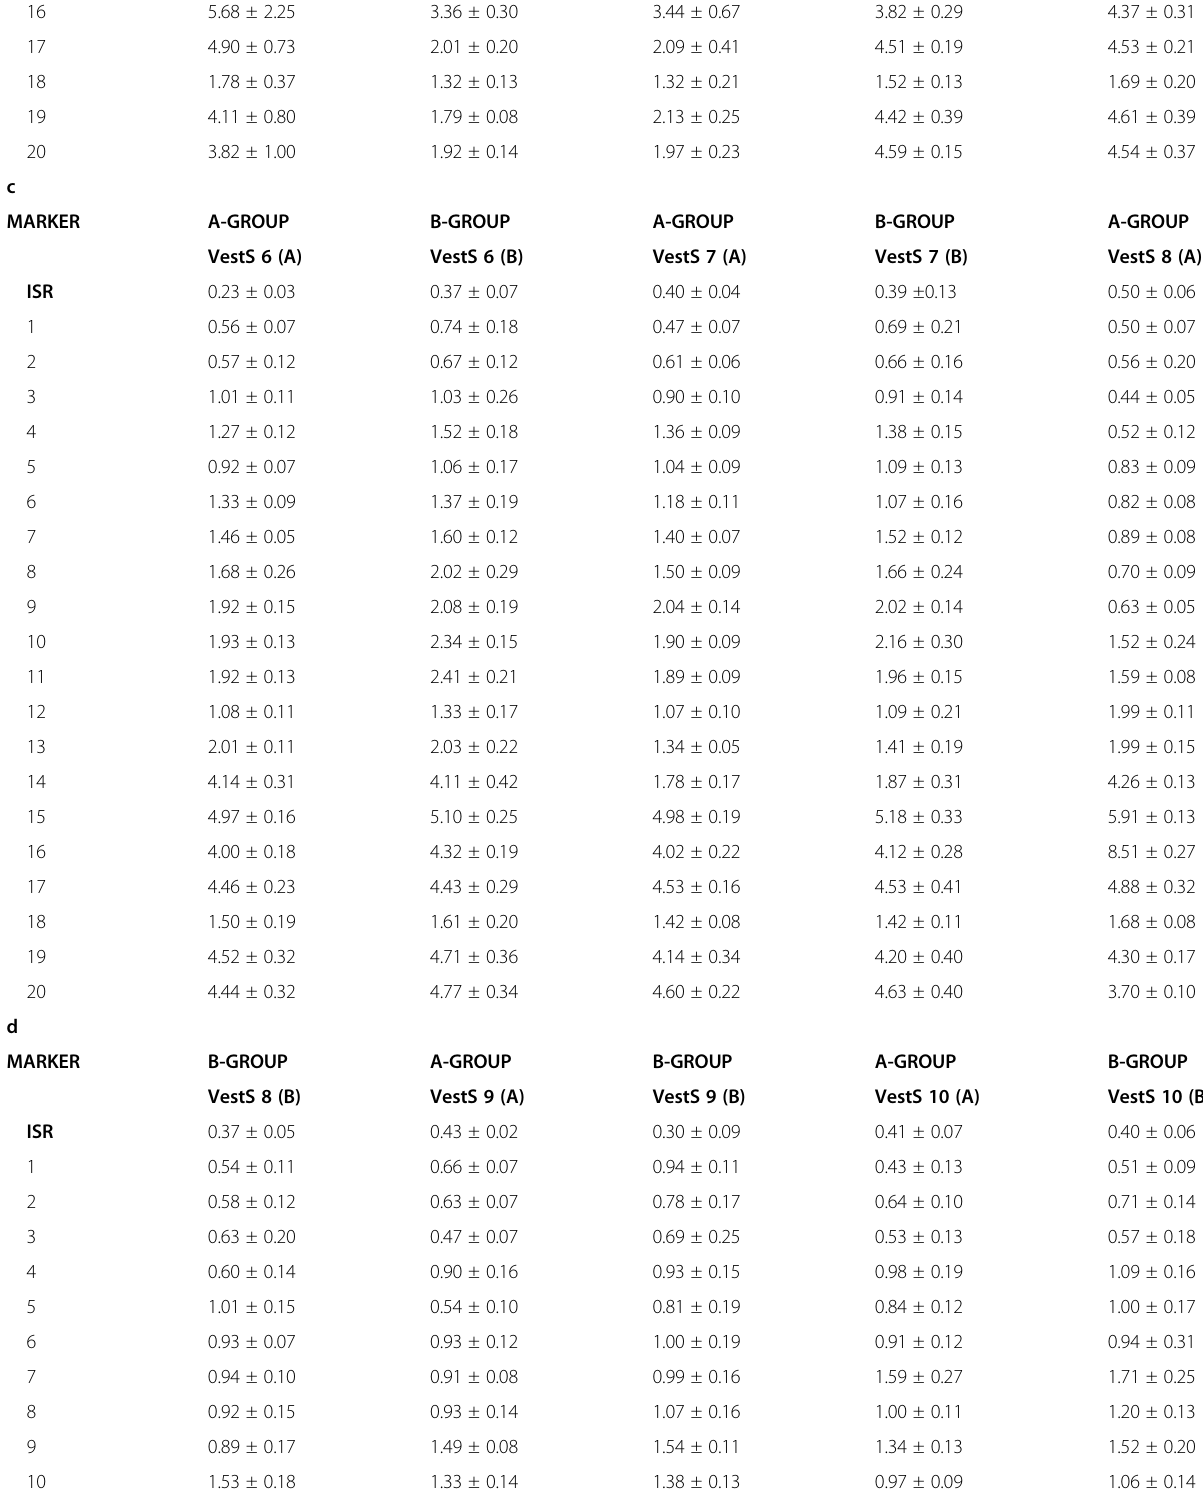
Table 3 Precision of two different splints (MaxS and VestS) measured at twenty bone marker points. Group A was measured immediately after completion. Group B was reattached ten times and measured. Accuracy (Mean ± SD) as difference between position of the targets in the CT and the targets position using a navigation system